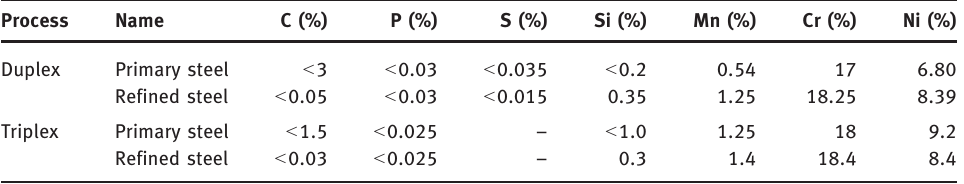
Table 1: Chemical compositions of 300 series stainless steel in duplex and triplex processes.